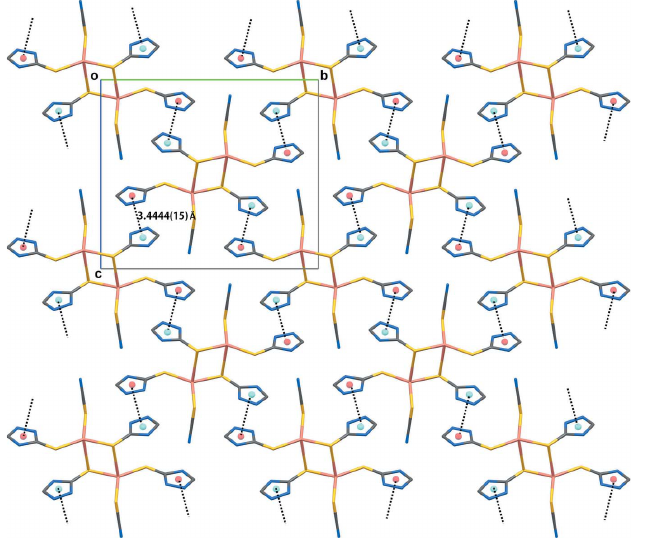
Figure 3 The face-to-face (cid:4) – (cid:4) stacking of (I).